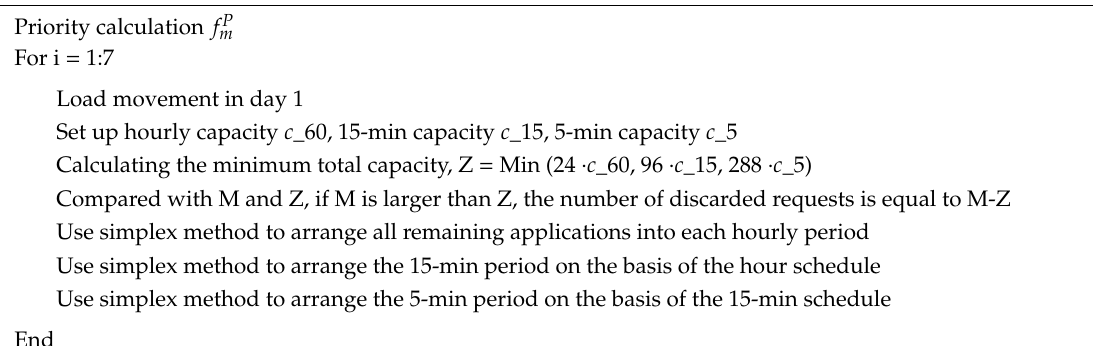
Algorithm 1. Iterative linear integer programming algorithms based on data-splitting.